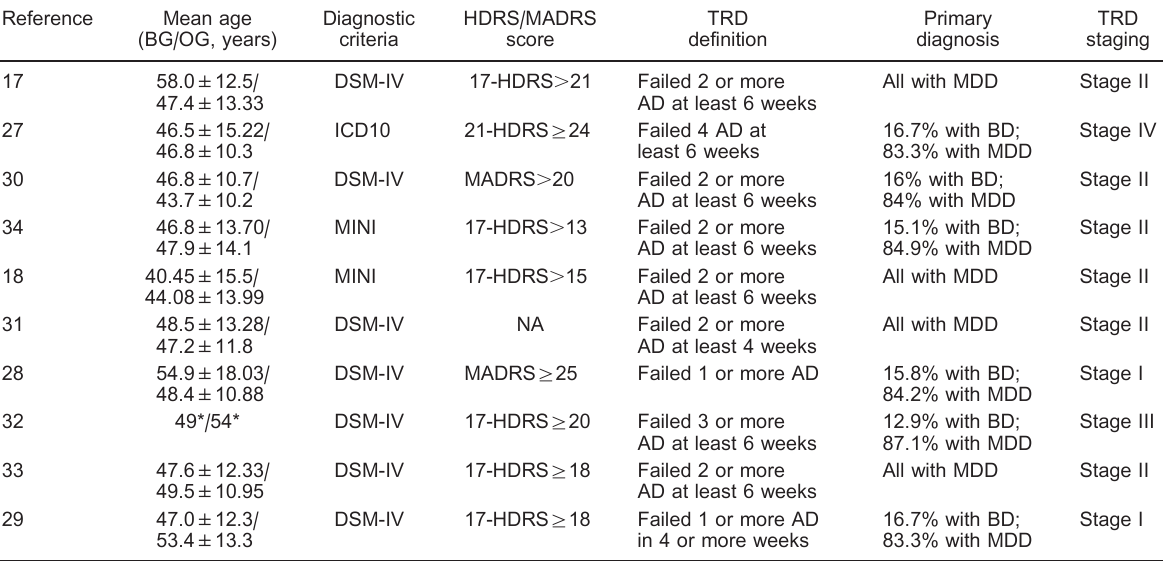
Table 1. Characteristics of patients in the included trials.